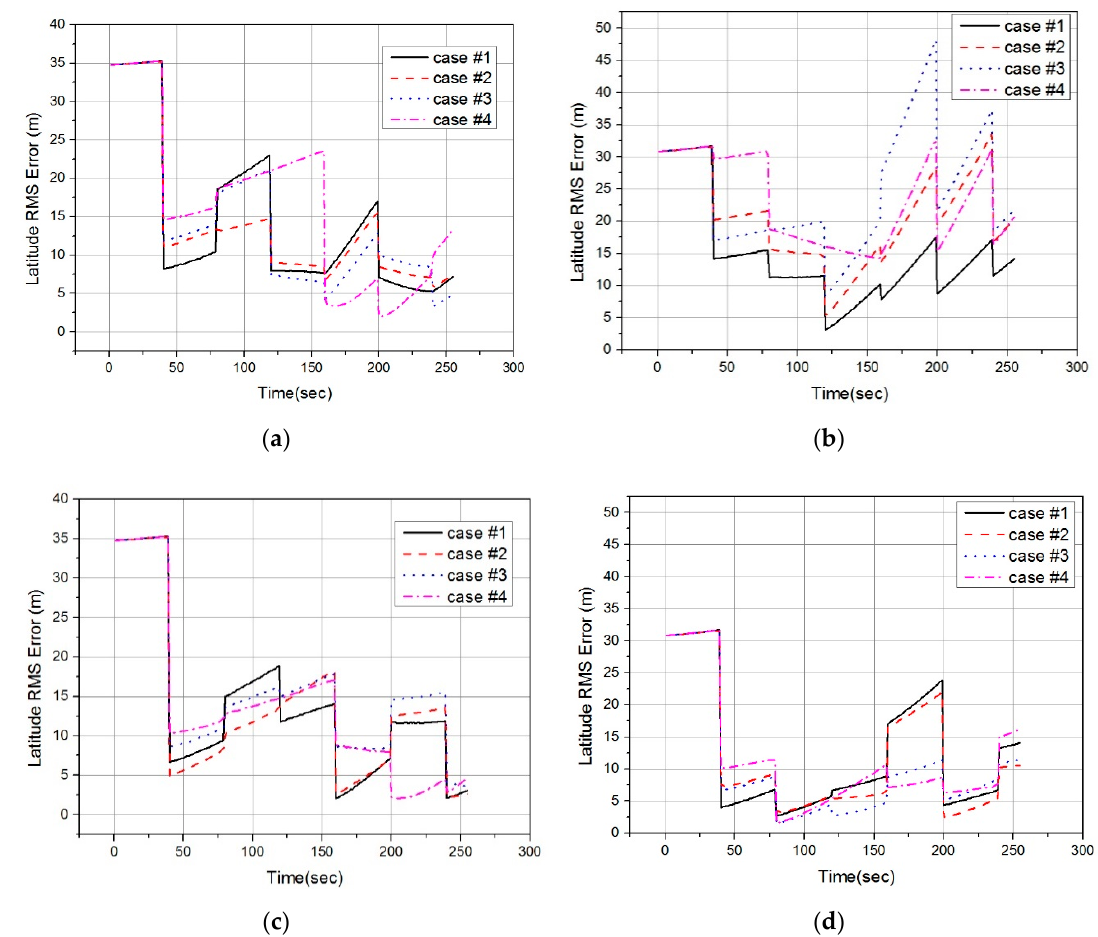
Figure 19. Monte Carlo simulation result graphs: ( a ) latitude RMS error for Conventional method; ( b ) longitude RMS error for Conventional method; ( c ) latitude RMS error for Proposed method; ( d ) longitude RMS error for Proposed method.